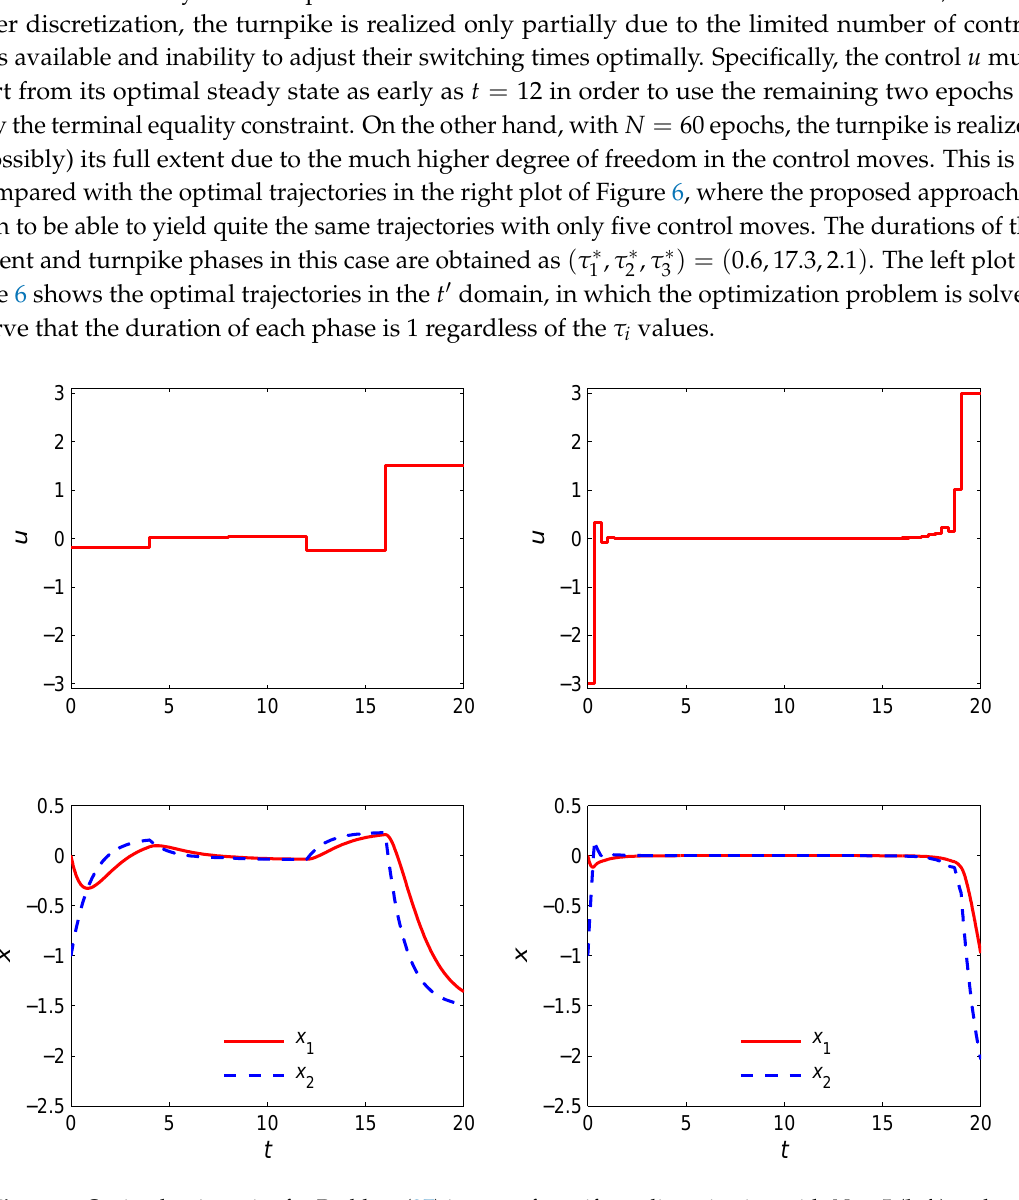
Figure 5. Optimal trajectories for Problem (37) in case of a uniform discretization with N = 5 ( left ) and N = 60 ( right )